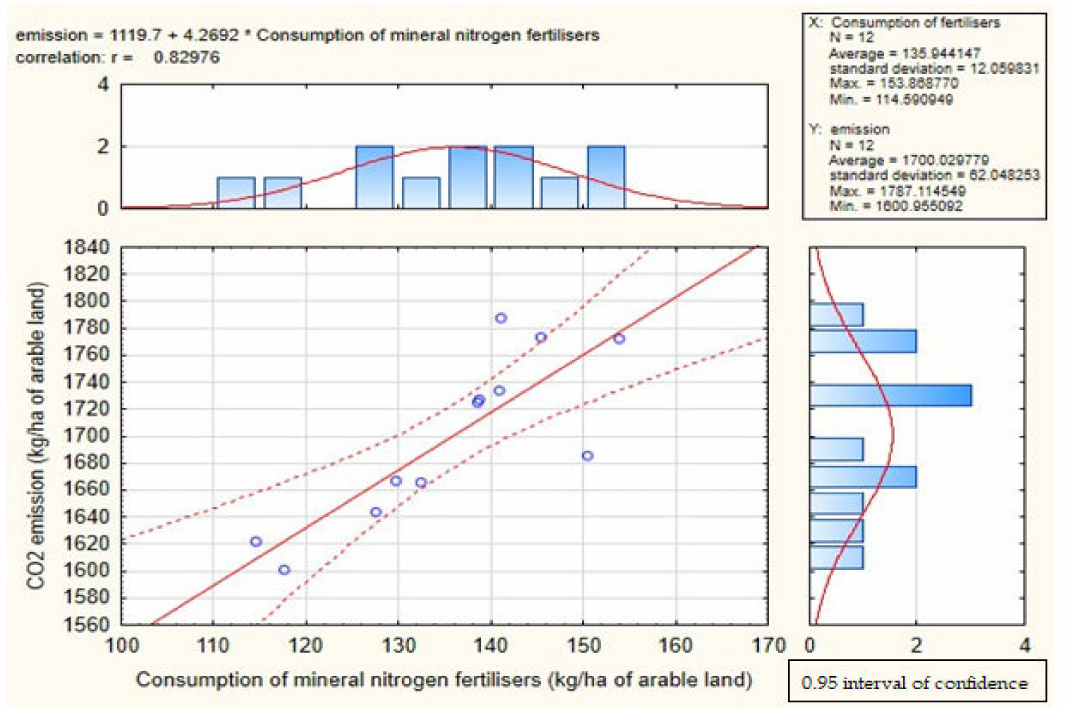
Figure A7. Results of correlations analysis: Germany. Source: own calculation based on Eurostat. Note: purple dot: observation, red solid line: linear function, red dashed lines: 95% interval of